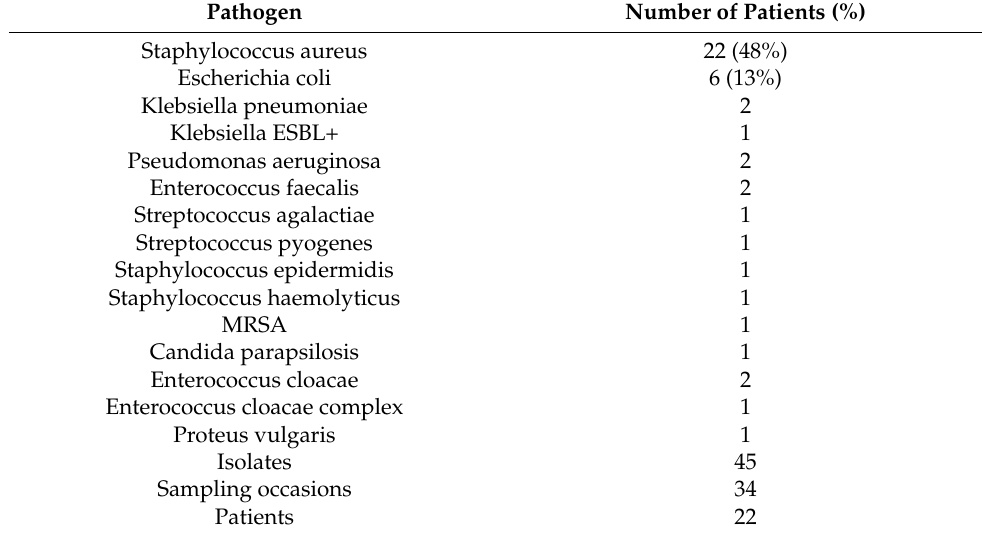
Table 3. Pathogens identified in blood cultures from 22 burn